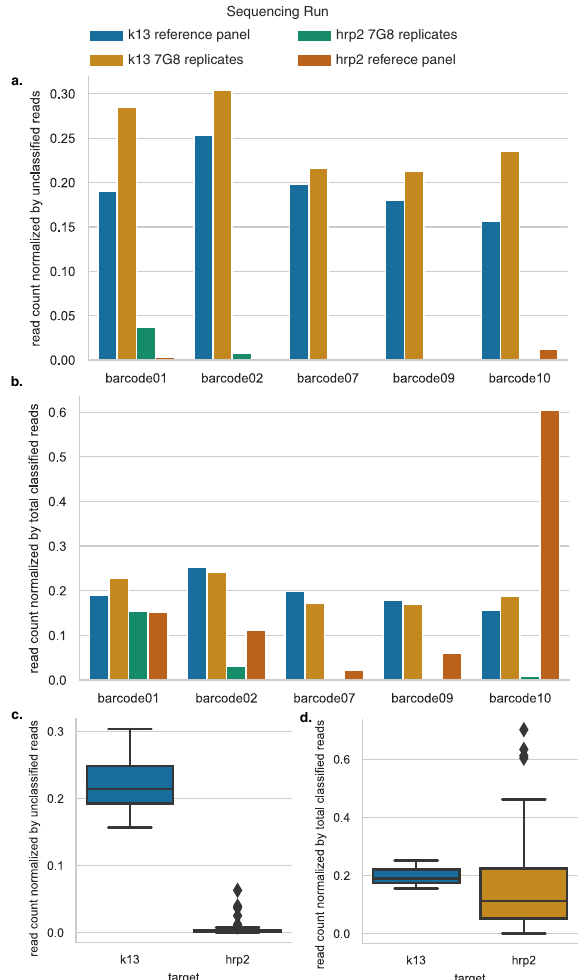
Figure 2. Differences between k13 and pfhrp2 barcode performances with the custom-barcoding protocol. ( a ) Barcode performance across two k13 and two pfhrp2 control sequencing runs, between five barcodes, as measured by barcode read count normalized against the amount of unclassified (not barcoded or properly de-multiplexed reads) reads in the sequencing run. One sequencing run for each target was performed on a diverse reference panel (see blue and green bars) and replicates of control strain 7G8 (see orange and red bars). ( b ) Read counts normalized by total passing reads across two k13 and two pfhrp2 control sequencing runs, between five barcodes. ( c ) Summarized barcode performance (barcode read counts normalized by unclassified reads) across multiple sequencing runs for k13 (n = 2) and pfhrp2 (total n = 9; reference panel sequencing runs, n = 3; barcode performance test, n = 6). ( d ) Summarized barcode performance (barcode read counts normalized by total classified reads) across multiple sequencing runs for k13 (n = 2) and pfhrp2 (total n = 9; reference panel sequencing runs, n = 3; barcode performance test, n =